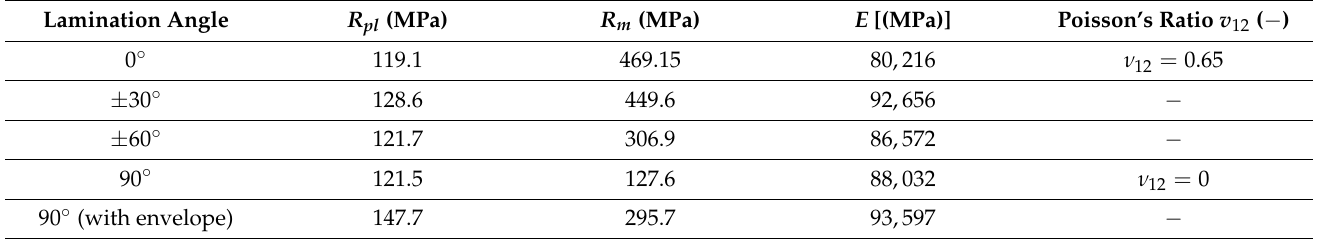
Table 7. Results collected from tensile strength tests.